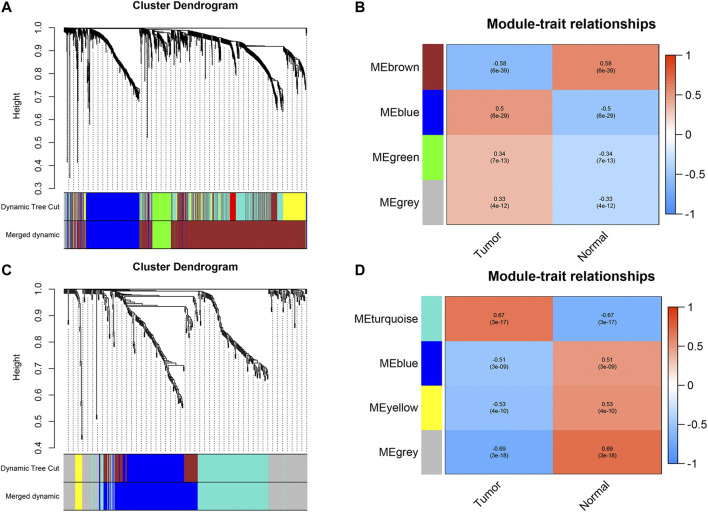

(A and B) Dendrogram of all differentially expressed genes in TCGAMIBC and GSE13507 datasets clustered based on a dissimilarity measure (1-TOM). (C and D) The heatmaps were depicted to show the correlation between module Eigengenes and clinical status (including tumor and normal status), correlation coefficients and p-values were showed in every module.